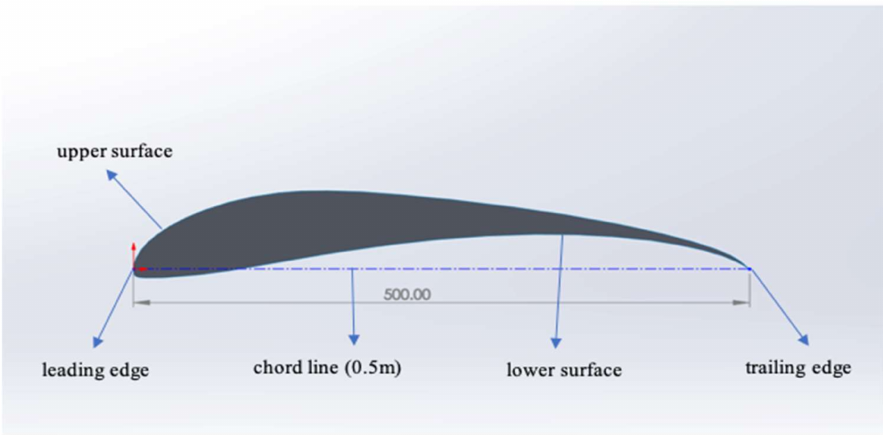
Figure 7. A standard Selig S1223 Airfoil (wing root)